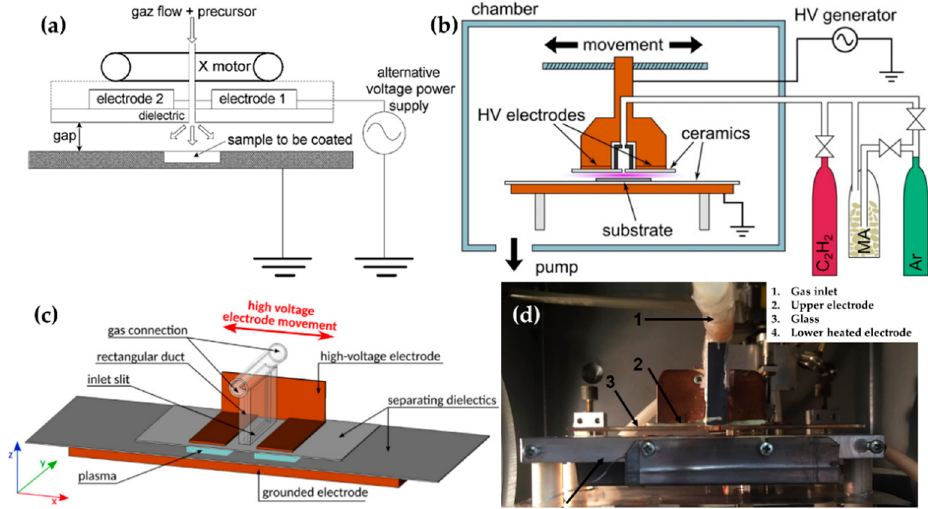
Figure 7. The polymerization systems using planar DBD with a movable top electrode (powered electrode) of ( a ) Bardon et al. [74,89], ( b ) Manakhov et al. [75], and ( c ) Obrusník et al. [76], and the image of the DBD system of ( d ) St’ahel et al. [77].